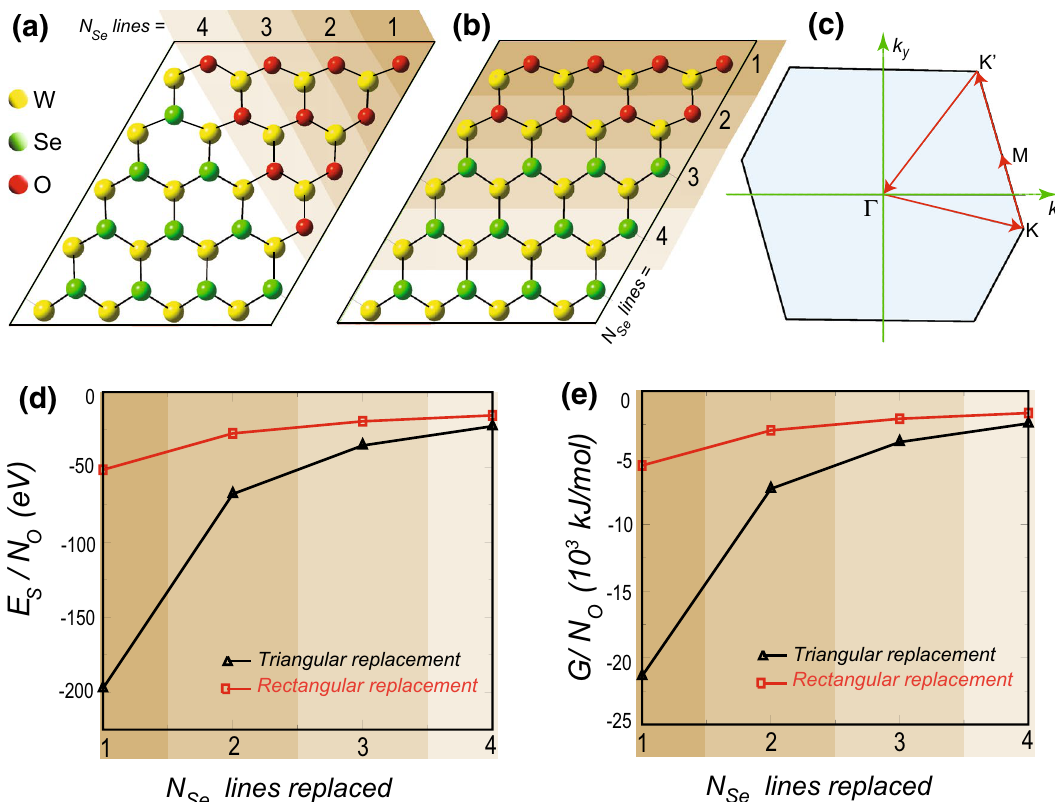
Figure 1. 4 × 5 super cell of 2D monolayer of WSe 2 with ( a ) triangular and ( b ) rectangular O substitution, respectively. The different shades, along with the numeric values 1–4 show the lines of Se atoms replaced by O upon gradual oxidation. ( c ) The distorted hexagonal first Brillouin zone of 4 × 5 super cell with high-symmetric points. ( d ) The stabilization energy ( E S ) and ( e ) the molar Gibbs free energy ( G ) at room temperature (298 K) and 0 GPa pressure, normalized to the number of substituted O atoms ( N O ) as a function of the number of Se lines replaced in triangular (triangle) and rectangular (square) fashion. The shades in ( d ) and ( e ) correspond to that of ( a ) and ( b ).